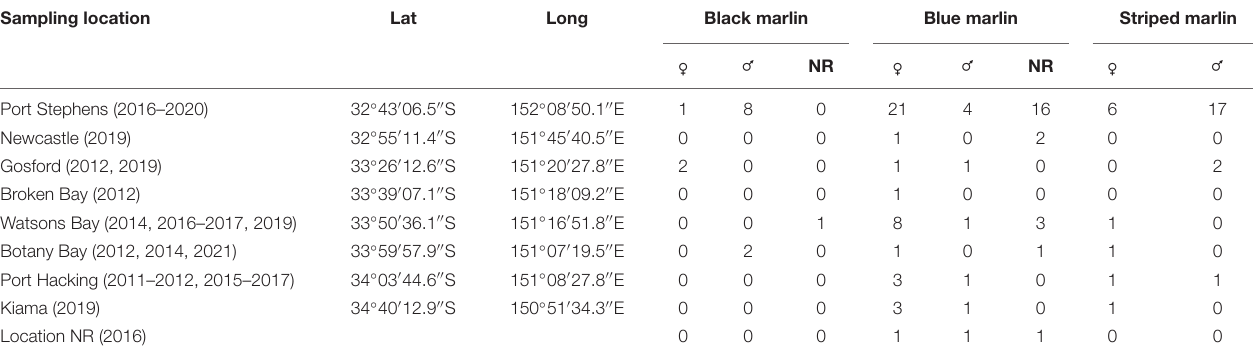
TABLE 1 | Locations from which tissue was collected and the sample size (number of individuals) of tissue collected for three different marlin species: black marlin ( Istiompax indica ), blue marlin ( Makaira nigricans ), and striped marlin ( Kajikia audax ). Sampling location Lat Long Black